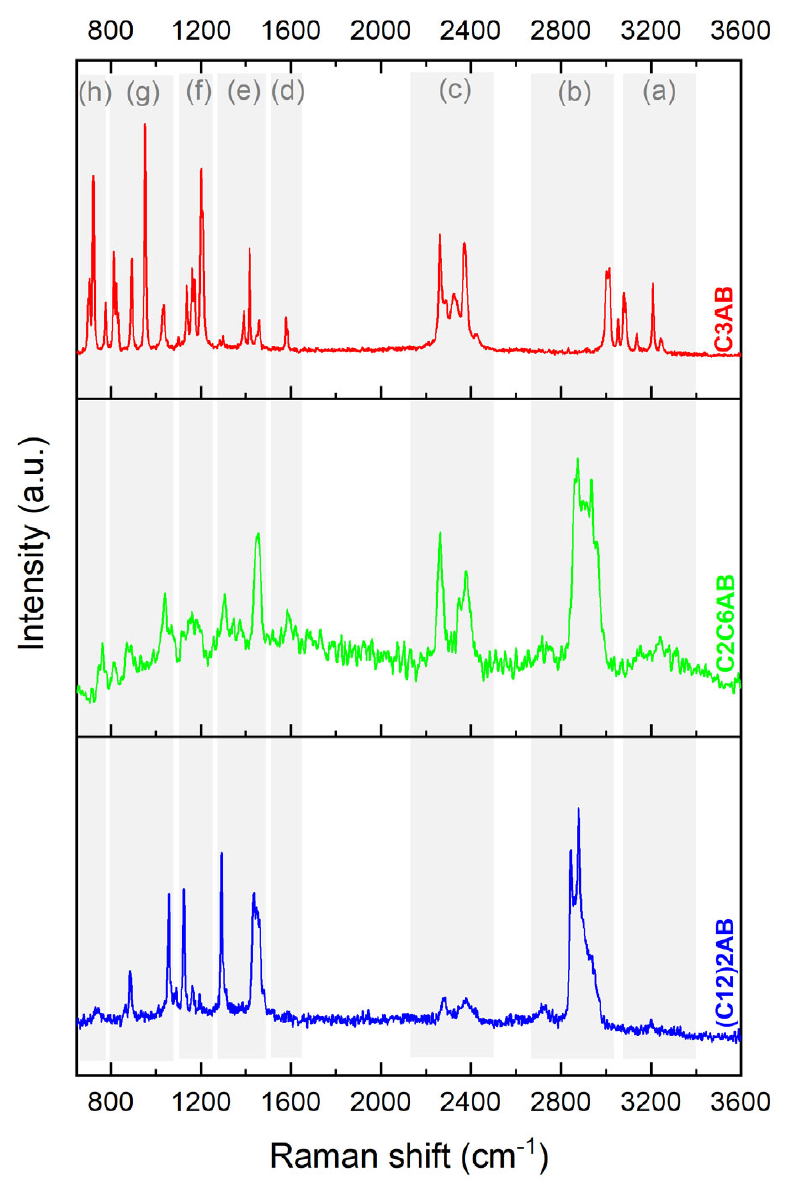
Figure 5. Raman spectra of C3AB, C2C6AB and (C12)2AB. The bands are assigned: (a) N − H stretching; (b) C − H stretching; (c) B − H stretching; (d) N − H deformation; (e) C − H deformation; (f) B − H deformation; (g) C − N and C − C stretching and C − H deformation; (h) B − N stretching.